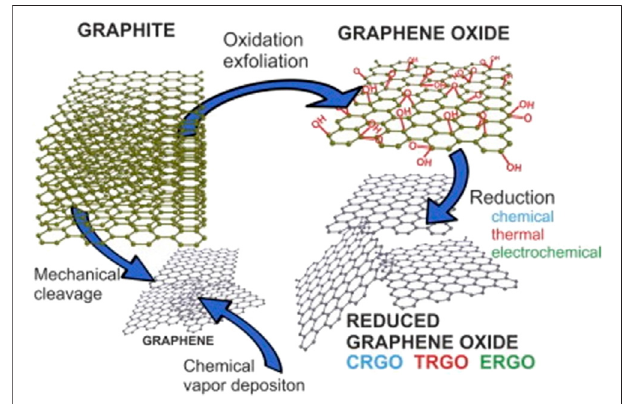
FIGURE 1 | Schematic diagram on the preparation of graphene and Graphene Oxide (GO) (Filip and Tkac,